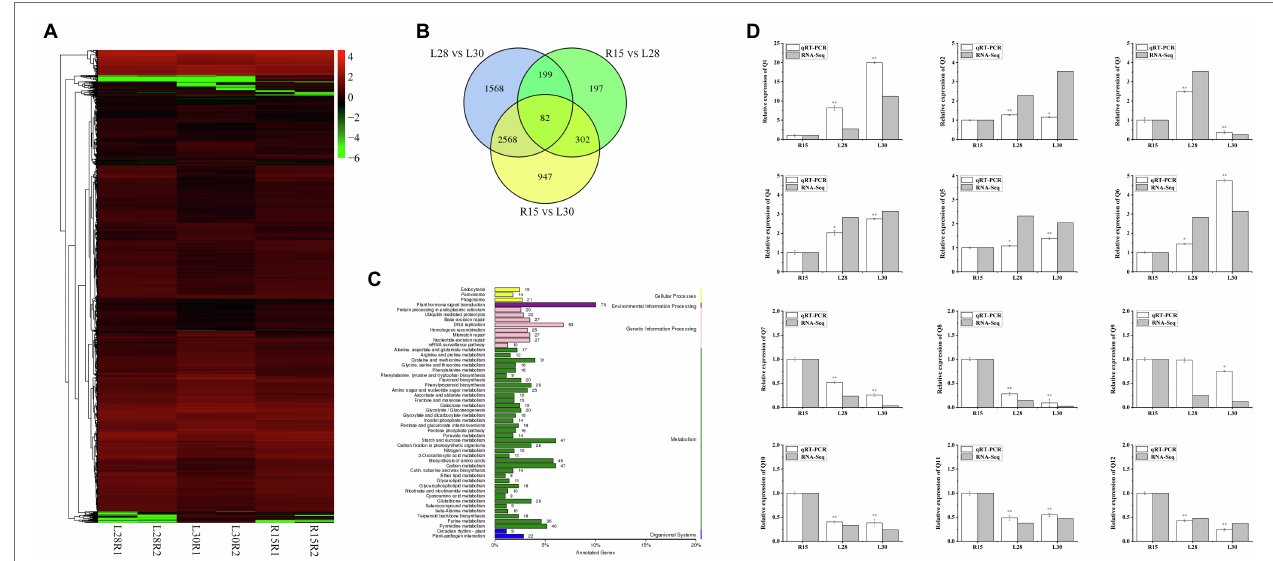
FIGURE 2 | RNA-seq analysis of cotton R15, L28, and L30 seedlings. (A) Cluster diagram of expression patterns of all differentially expressed genes (DEGs). The horizontal axis represents the clustering results for the R15, L28, and L30 materials, and the vertical axis represents the clustering of the DEGs. Each column represents one sample of the plant materials and each row represents a different gene. The color indicates the log (FPKM +1) expression level of the gene in the sample. (B) Venn diagram of DEGs. Each circle in the plot represents a differential grouping, and the intersection of the circles represents the common DEGs, with the corresponding number of genes identified in the set. (C) KEGG classification plot of DEGs. The vertical axis is the name of the KEGG metabolic pathway, and the horizontal axis is the number of genes annotated to the pathway as a proportion of the total number of genes annotated. The value beside each bar is the number of genes annotated for each pathway. (D) Expression patterns of 12 genes in R15, L28, and L30 determined by RNA-seq and qRT-PCR analyses. Error bars indicate the standard error ( n = 3 biological replicates). * p < 0.05, ** p < 0.01 (Student’s t -test).